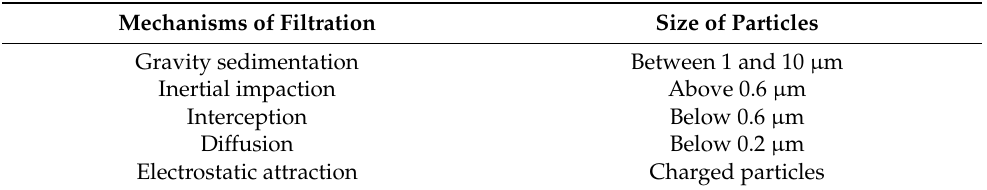
Table 1. Mechanisms of filtration and respective particle sizes to be filtered